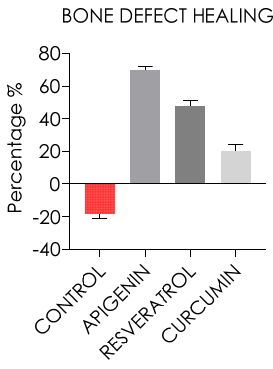
Figure 13. Bone defect healing of the control, apigenin, resveratrol, and curcumin groups after 30 days from the surgery. A negative defect repair of the control group was present, while the apigenin administration showed the highest level of defect healing.